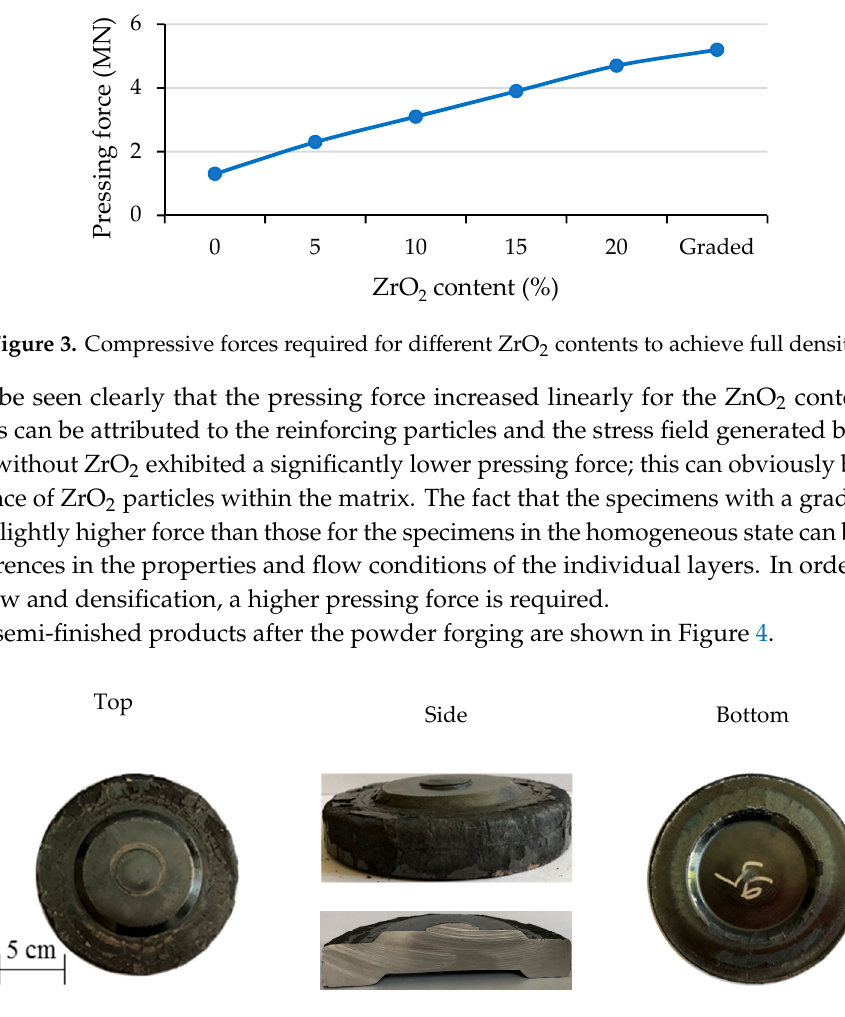
Figure 4. Specimen with ZrO 2 content of 5%.